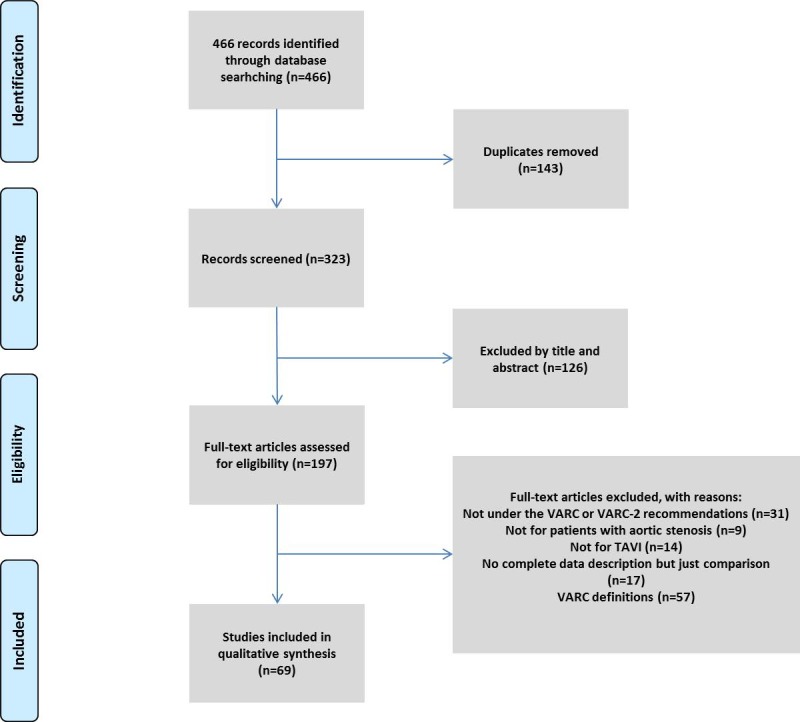
PRISMA Flow diagram of study selection.